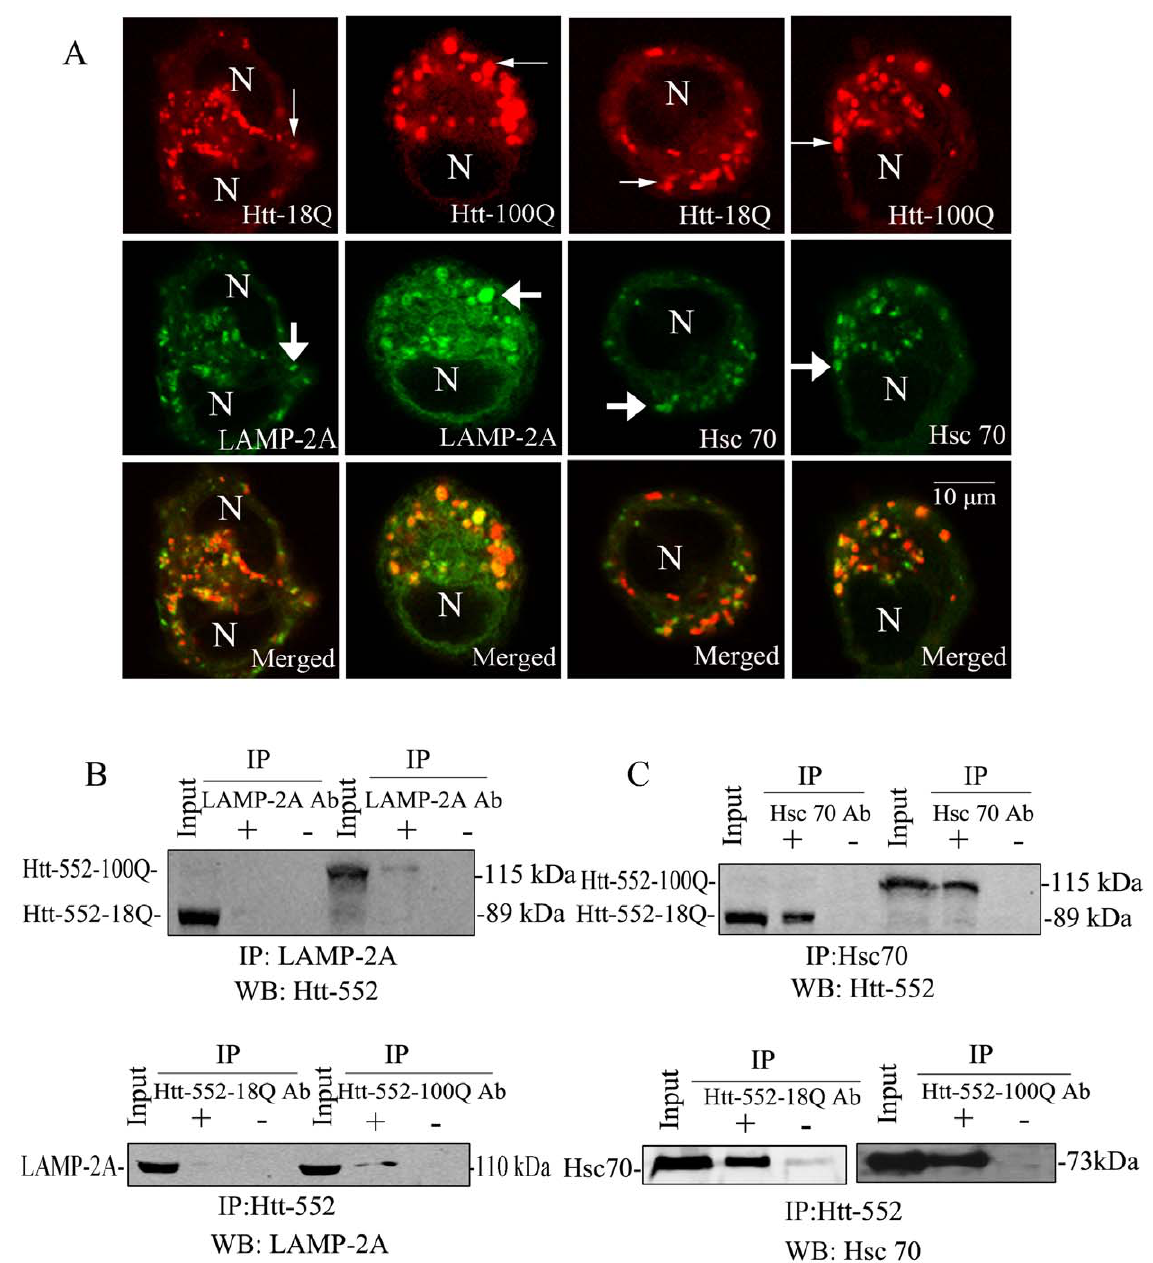
Figure 2. Association of Htt-552 and exogenous CMA component proteins. (A) Exogenous expressed LAMP-2A or Hsc70 co-localized with exogenous Htt-552-18Q and Htt-552-100Q in HeLa cells. Cells were transfected with Htt-552 for 48 h and fixed with methanol, blocked, and processed for double immunofluorescence with antibodies against LAMP-2A (green), Hsc70 (green) and Htt-552 (red). Merged images of both channels are shown at the bottom. N: nucleus. Thin arrows point to Htt-552 immunoreactivity. Thick arrows point to lysosomes. The scale bar=10 m m. (B) Co-immunoprecipitation of exogenous expressed LAMP-2A with exogenous Htt-552. Upper panel: PC12 cell were transfected with PCDNA4-LAMP-2A for 72 h. Cell lysates were subjected to immunoprecipitation with anti-Htt antibody or no primary antibody and Western blot analysis was performed with anti-LAMP-2A antibody. Lower panel: PC12 cell were transfected with Htt-552 for 48 h. Cell lysates were subjected to immunoprecipitation with anti-LAMP-2A antibody or no primary antibody and Western blot analysis was performed with anti-Htt antibody. (C) Co- immunoprecipitation of exogenous expressed Hsc70 with Htt-552 from PC12 cells. Upper panel: PC12 cell were transfected with PCDNA4-Hsc70 for 72 h. Cell lysates were subjected to immunoprecipitation with anti-Hsc70 antibody or no primary antibody and Western blot analysis was performed with anti-Htt antibody. Lower panels:PC12 cell were transfected with Htt-552 for 48 h. Cell lysates were subjected to immunoprecipitation with anti- Htt antibody or no primary antibody and Western blot analysis was performed with anti-Hsc70 antibody. Ab: Antibody.